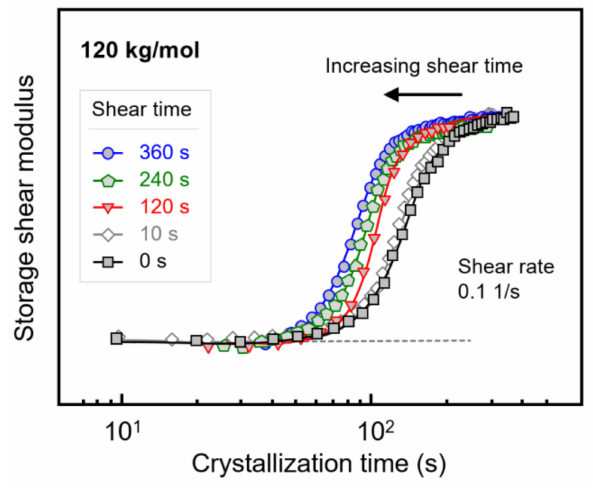
Figure 7. Storage shear modulus of PLLA with a molar mass of 120 kg/mol as a function of the crystallization time, after shearing the melt at 0.1 1/s at 135 ◦ C for different shear times.